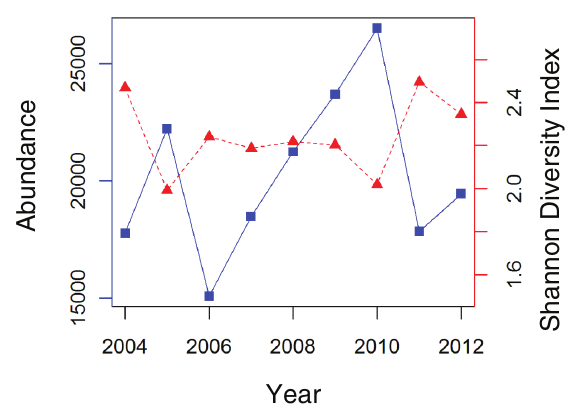
Figure 2. Waterfowl abundance and Shannon diversity